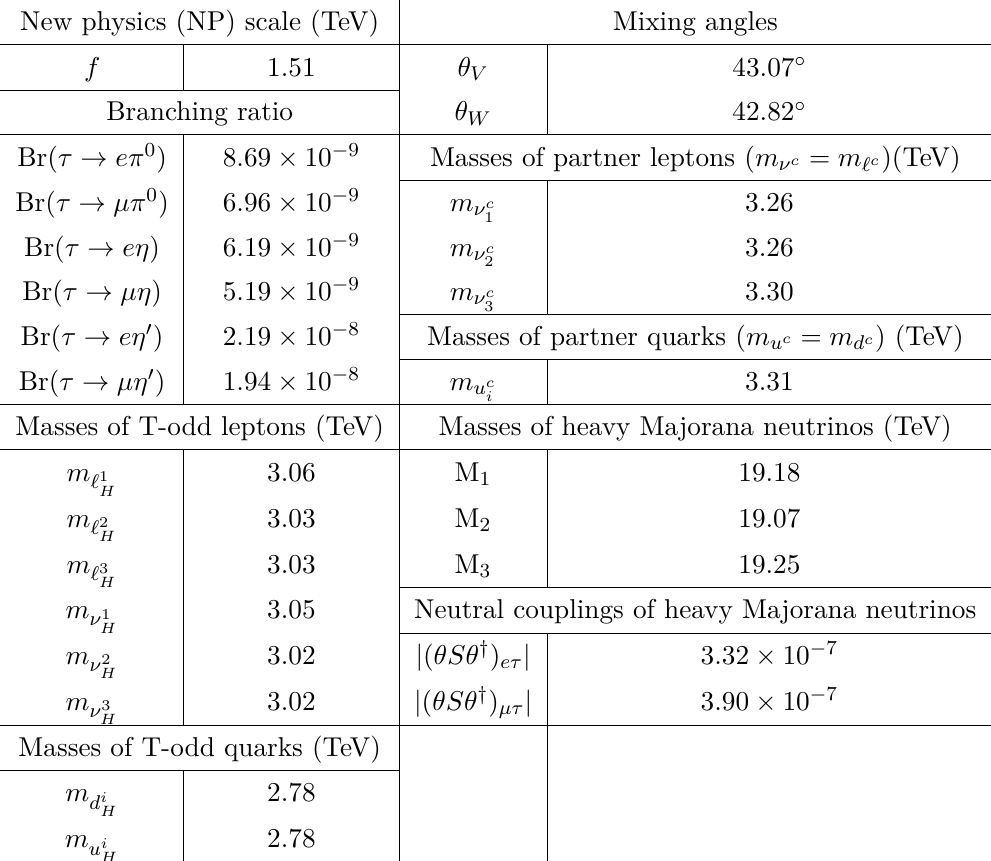
Table 4 . Mean values for branching ratios, masses of LHT heavy particles, mixing angles and neutral couplings obtained by Monte Carlo simulation of τ → ‘P ( ‘ = e, µ ) processes (case with Majorana